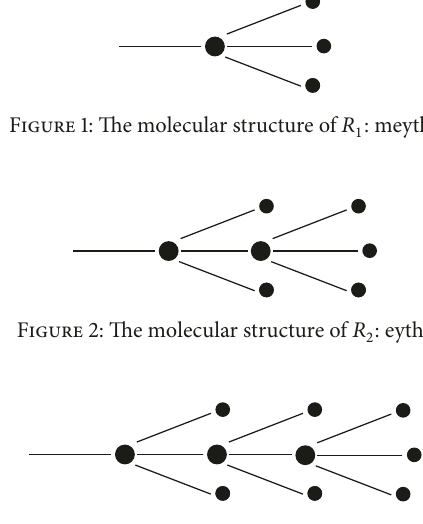
Figure 3: The molecular structure of 𝑅 3 :